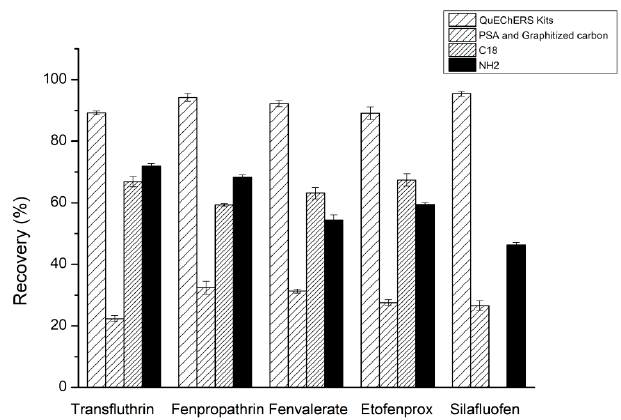
Figure 3. Effect of purification agent type on the recoveries of five pyrethroids.